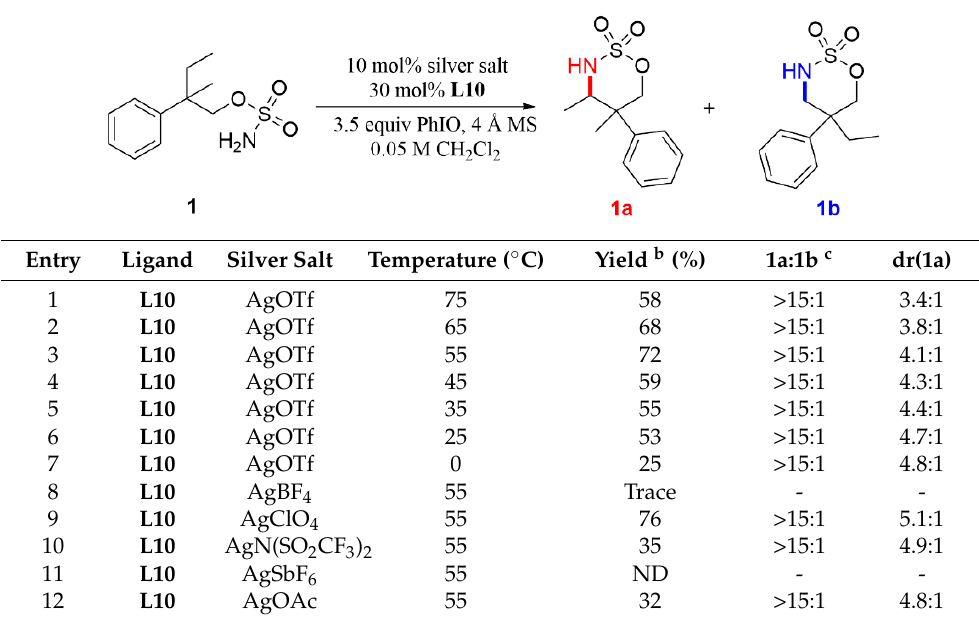
Table 2. The effects of reaction conditions on selective amination a .